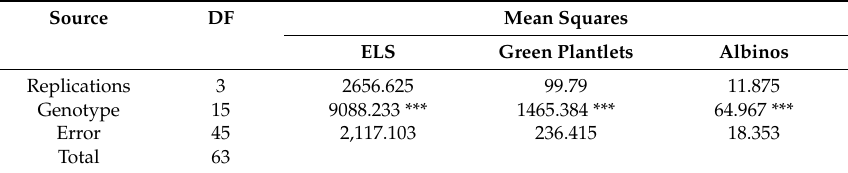
Table 4. Analyses of variance for number of ELS, green-, and albino